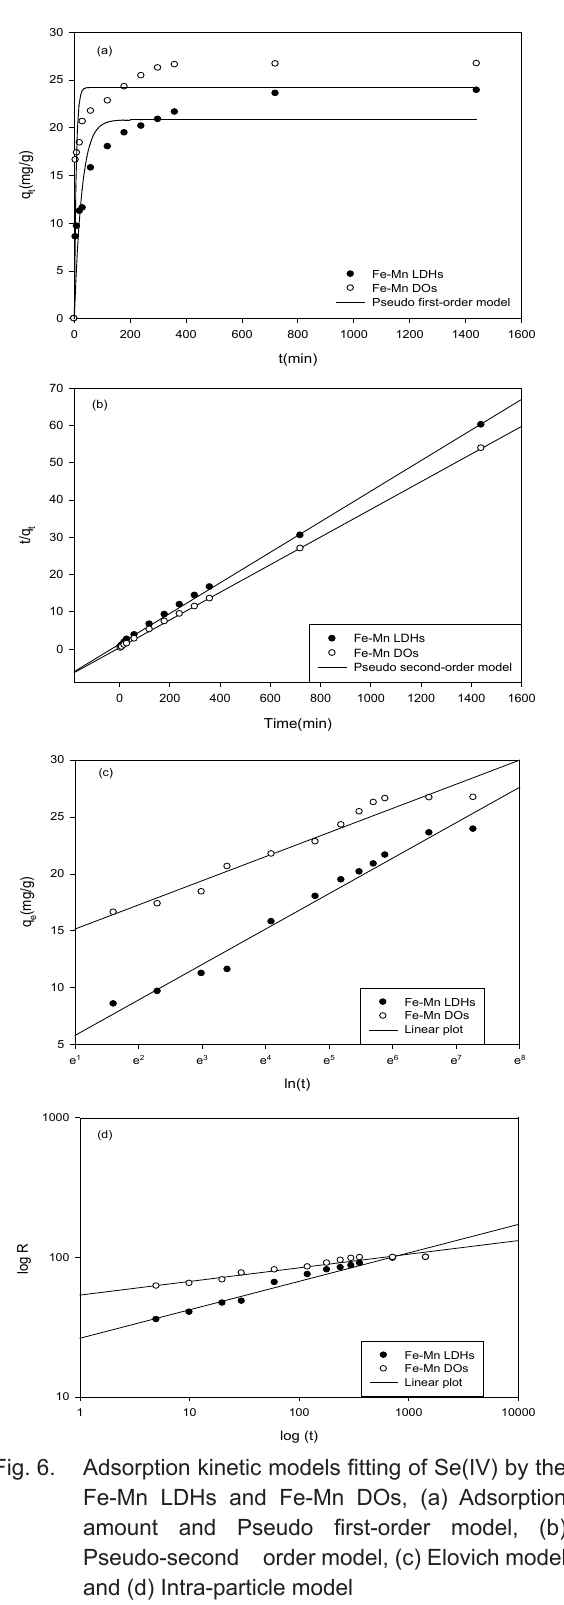
Fig. 6. Adsorption kinetic models fitting of Se(IV) by the Fe-Mn LDHs and Fe-Mn DOs, (a) Adsorption amount and Pseudo first-order model, (b) Pseudo-second order model, (c) Elovich model and (d) Intra-particle model Fe-Mn LDHs and Fe-Mn DOs spontaneously adsorption process of Se(IV) based on the change of Gibbs free energy.